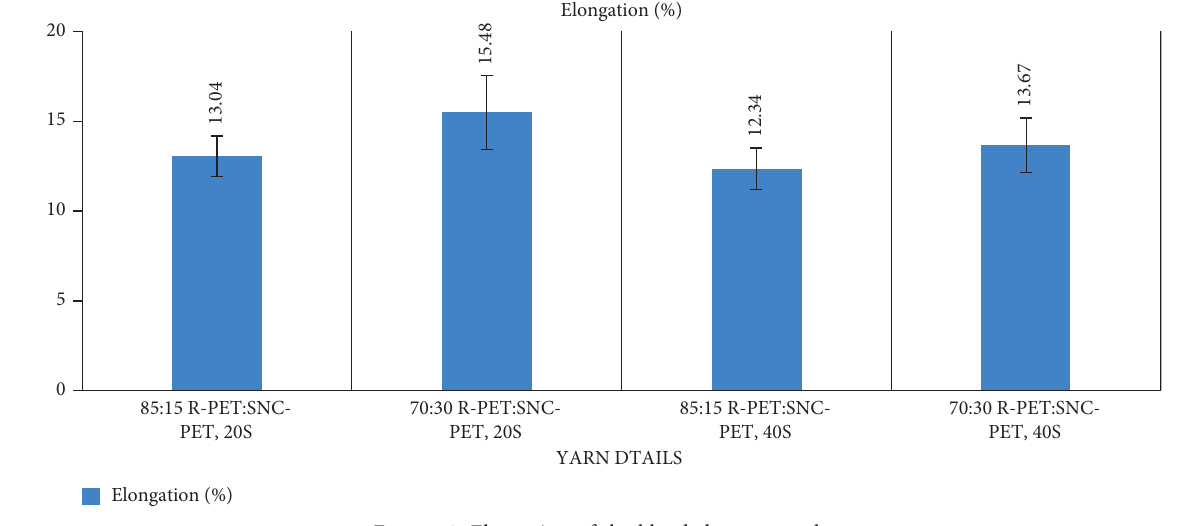
Figure 8: Elongation of the blended yarn sample.